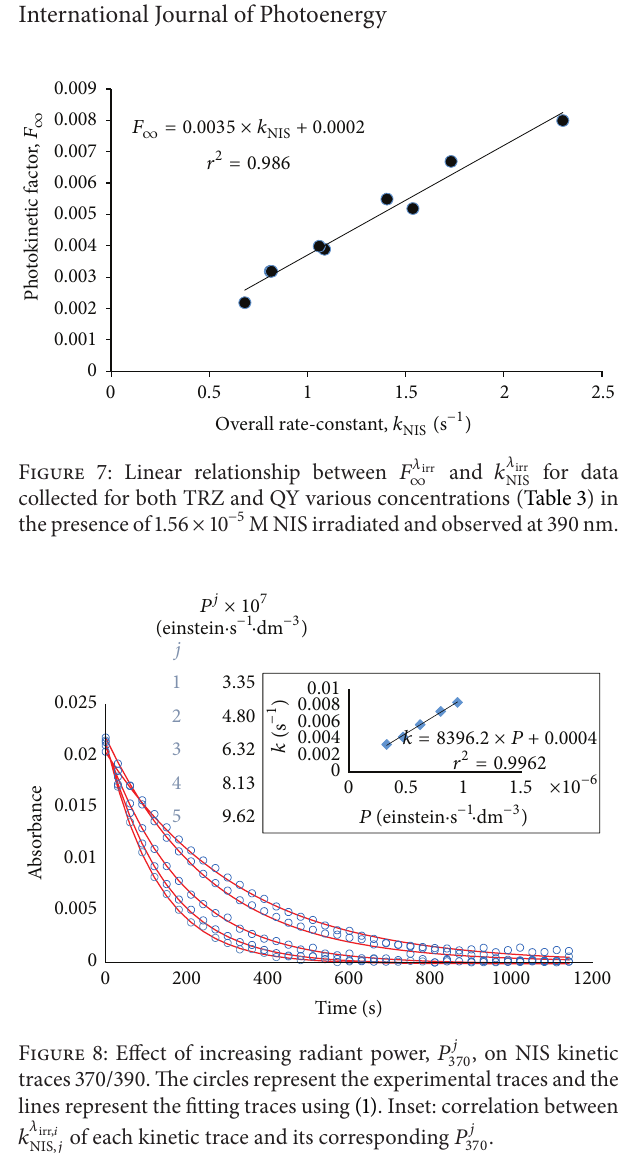
Figure 8: Effect of increasing radiant power, 𝑃 traces 370/390. The circles represent the experimental traces and the lines represent the fitting traces using (1). Inset: correlation between 𝑘 𝜆 irr ,𝑖 NIS ,𝑗 of each kinetic trace and its corresponding